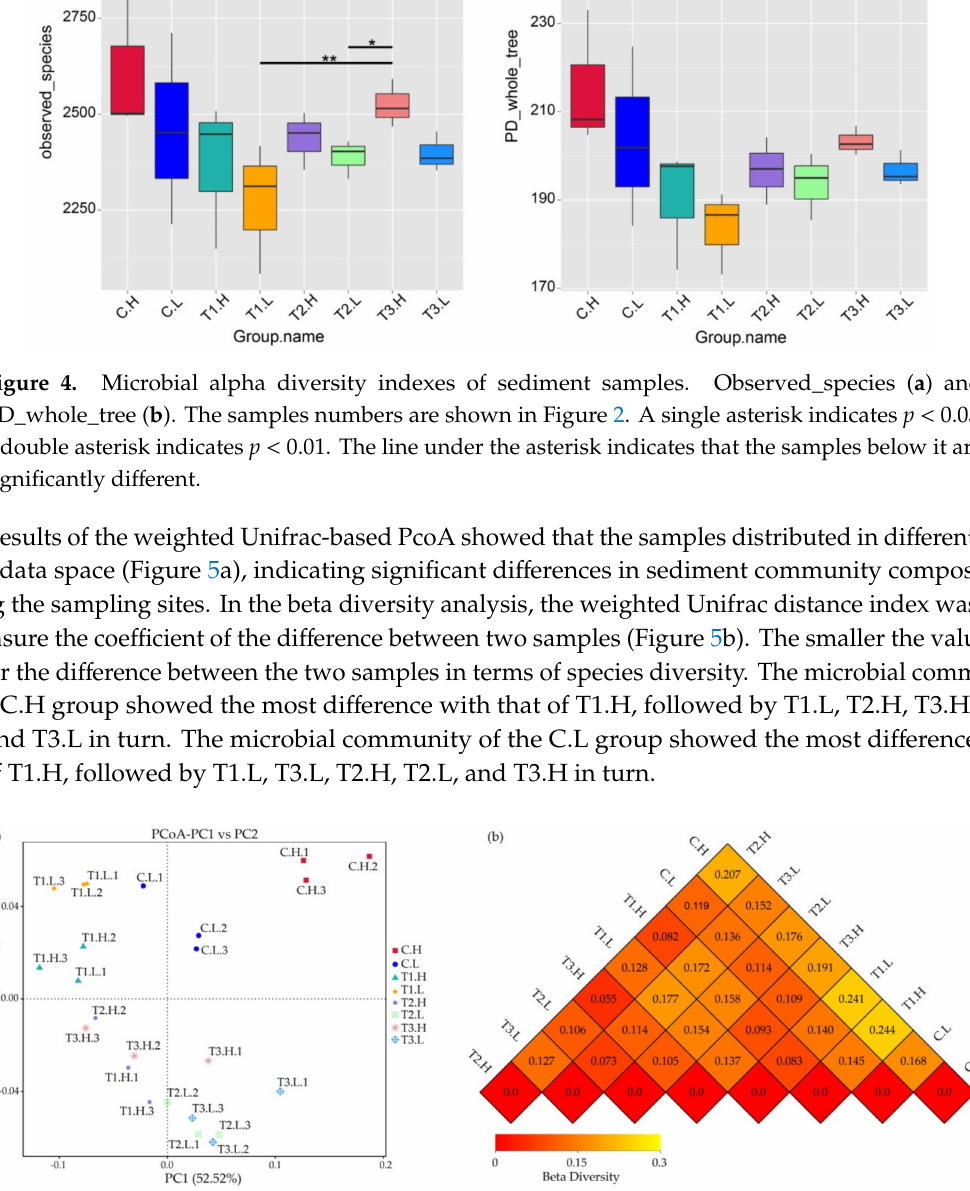
Figure 5. Microbial beta diversities of sediment samples. Weighted Unifrac-based PcoA ( a ) and beta diversity heatmap ( b ). The calculation of the beta diversity heatmap was based on the results of three duplicates in each group. The samples numbers are shown in Figure